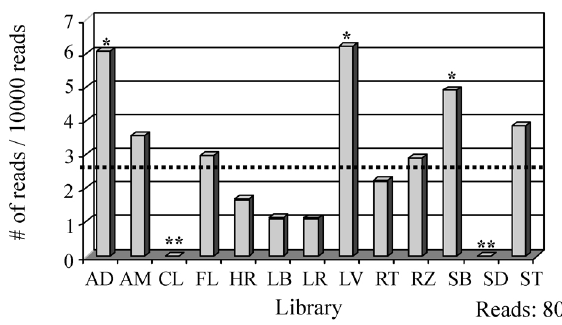
Figure 2 - Distribution of reads of the BER pathway. The dashed line rep- resents the average of reads observed in all tissues and those indicated by (*) or (**) are significantly different from the average (P < 0.01 as deter- mined by the T-test ).